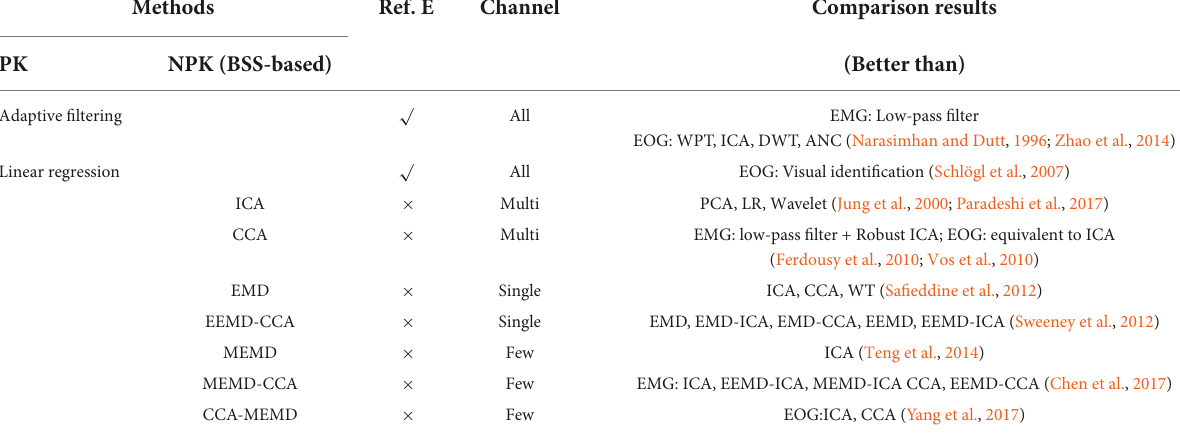
TABLE 1 Comparison of EMG and EOG artifacts removal